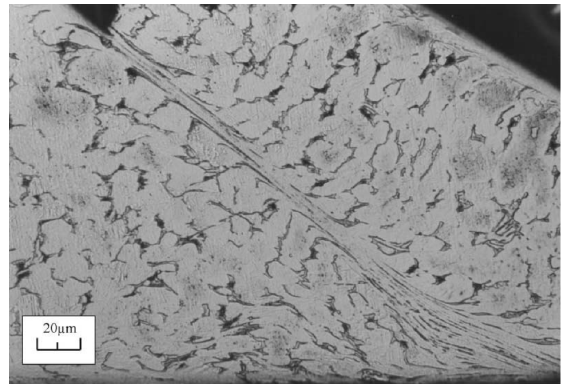
Figure 1. Adiabatic Shear Band formation during orthogonal cutting Titanium alloy [12].